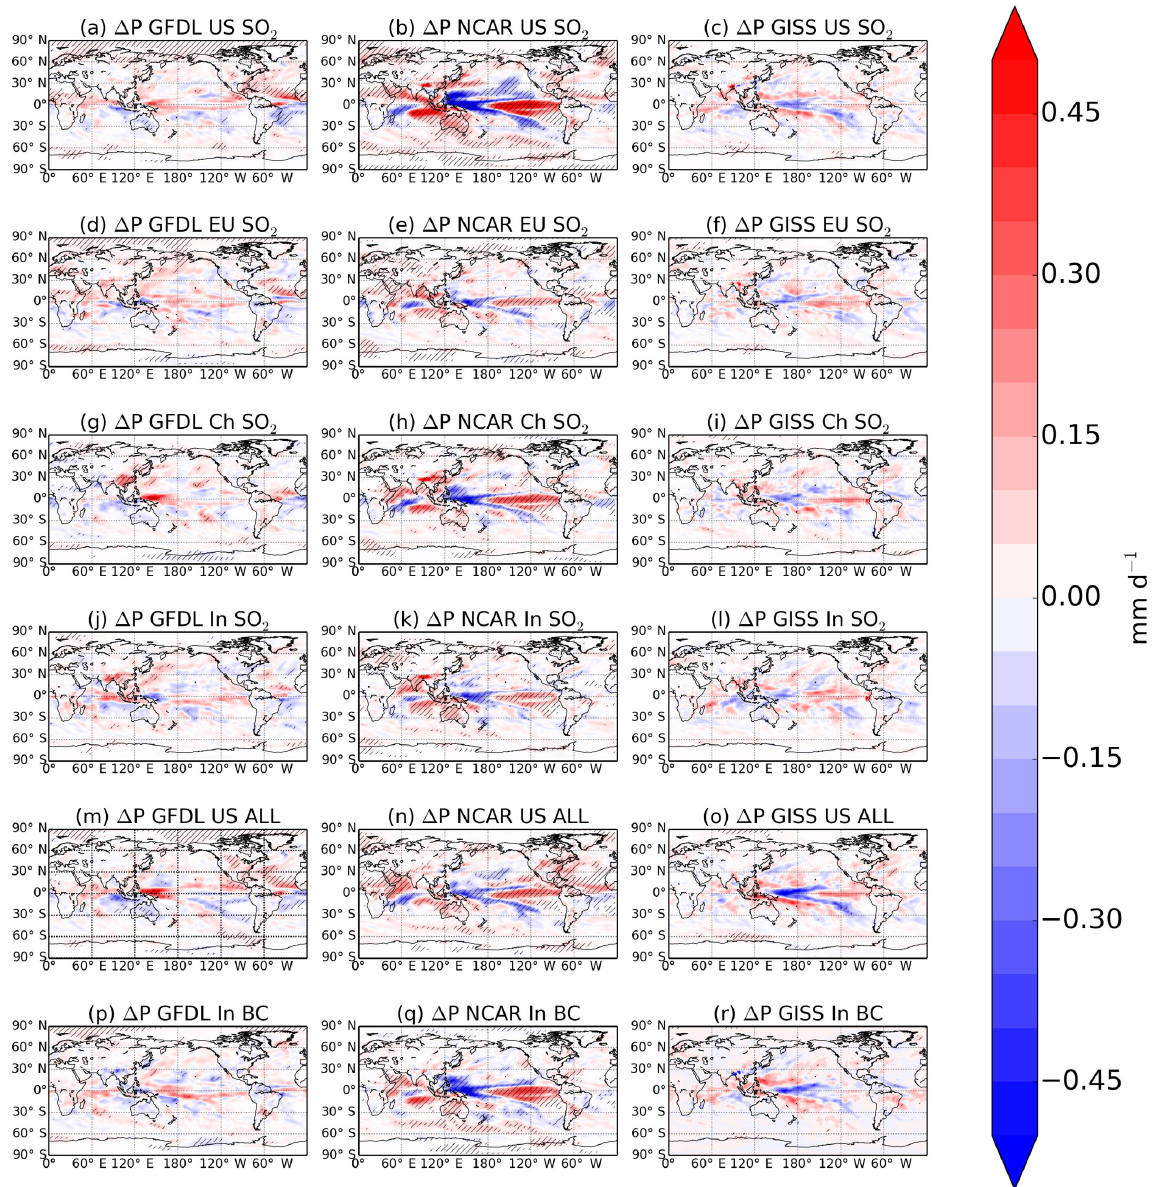
Figure 1. 200-year annual mean precipitation response to aerosol emissions decreases in each of the three models (GFDL-CM3, first column; NCAR-CESM1, second column; GISS-E2, third column) for several different regional emissions decreases (simulations indicated in figure titles; see Table 1). Hatching represents statistical significance at the 95% level according to a Student’s t